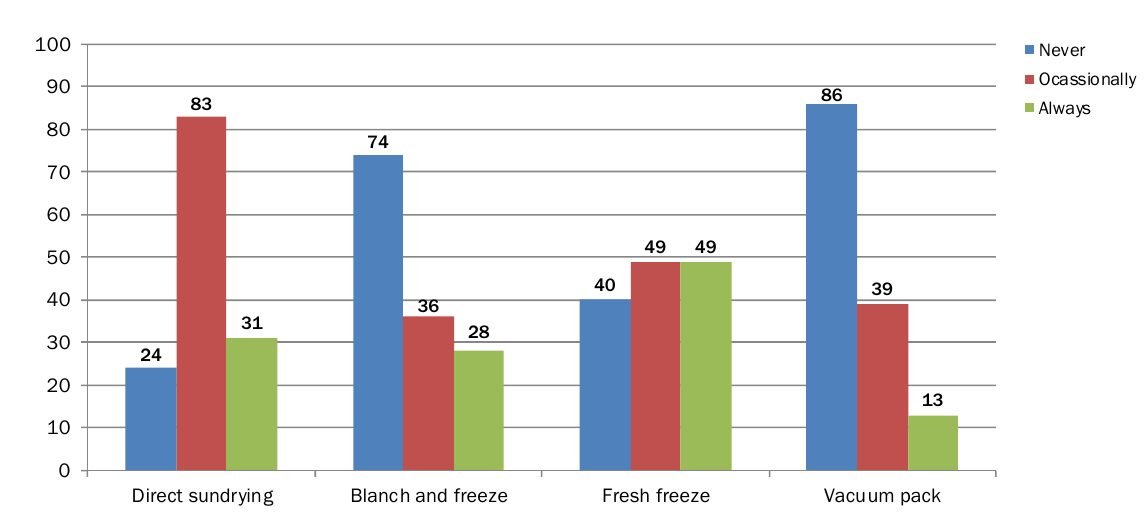
Figure 4. How Often Would You Buy Value-Added Cowpea Leaves? (count; N =147)